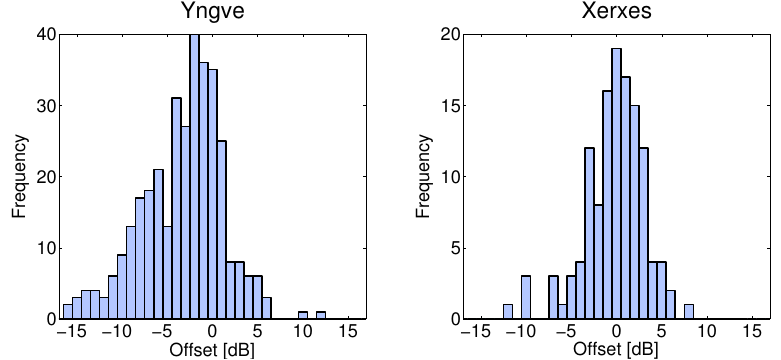
Figure 9. To the left is a histogram of the iteration offset of the large scale fading ( Ψ σ ), both before and after intersection Yngve. To the right is the same offset of intersection Xerxes, but with only measurements before the intersection, since no measurements were performed after the